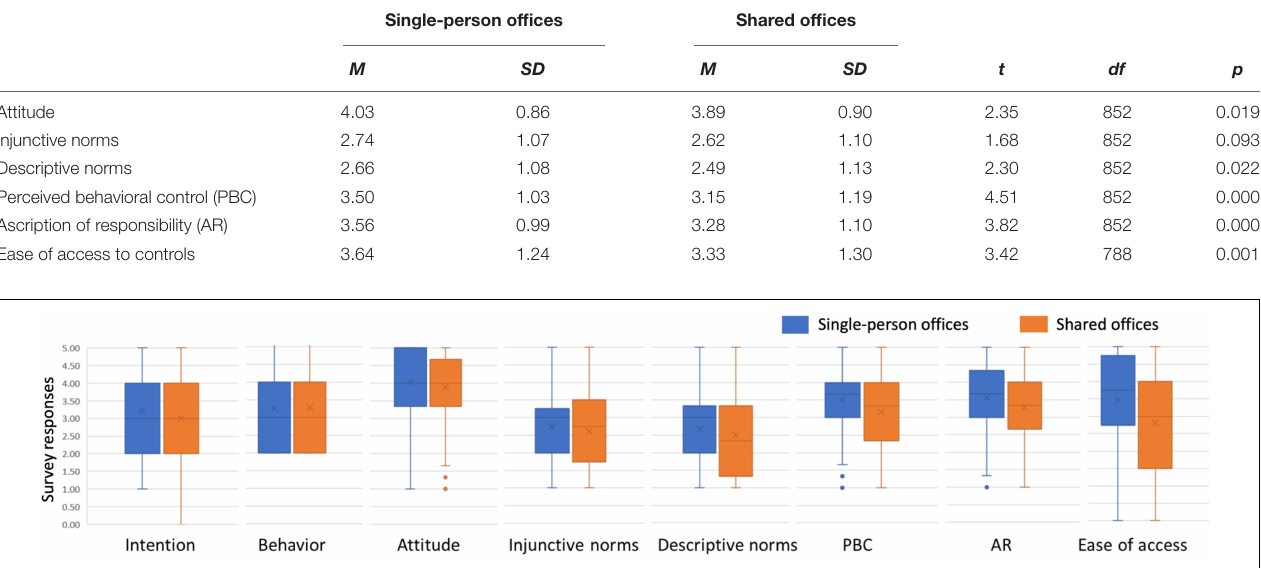
TABLE 2 | Comparisons on the means of independent variables in single-person and shared offices.